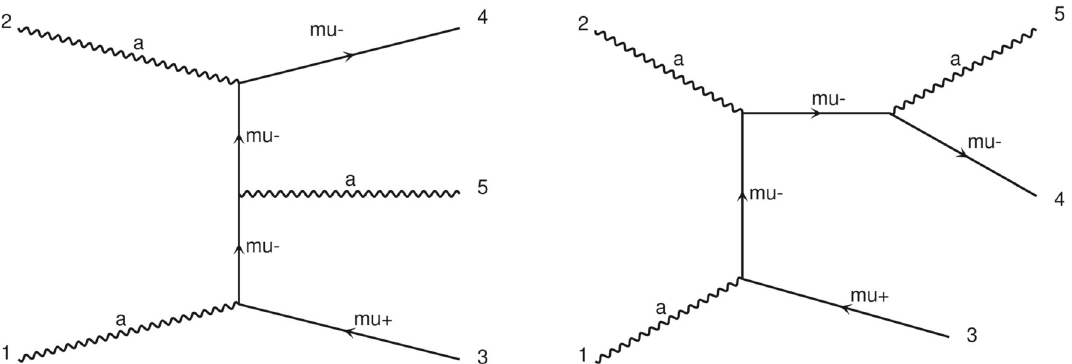
Fig. 4 Diagrams contributing to amplitude of γγ → μ + μ − γ production. Note that a stands here for photon